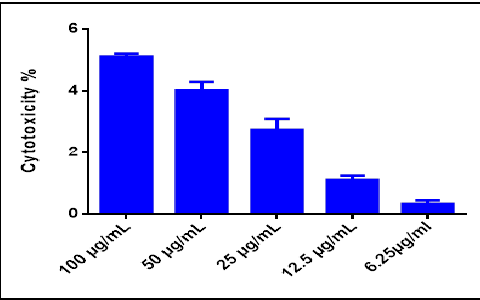
Figure 3. Control test. cytotoxicity chart using a different concentration of the tested sample (aqueous layer) against Vero